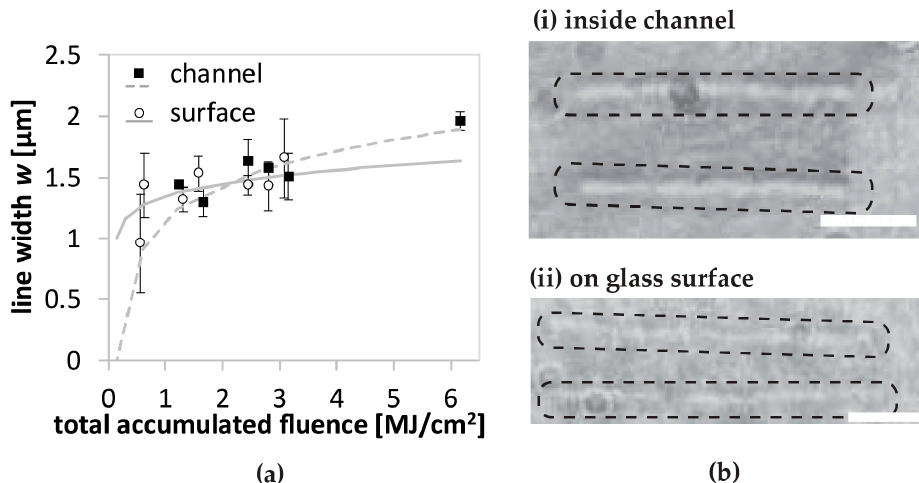
Figure 4. Writing of BSA line pattern inside a glass microchannel when using 50% w/w glycerol as a solvent and a 54-MHz, 525-nm femtosecond laser. ( a ) Line width w vs. total accumulated fluence for line patterns on top of the glass surface and inside the glass channel. Solid and dashed lines indicate fitting based on a two-photon polymerization scheme with R 2 = 0.524 (surface) and R 2 = 0.741 (channel), respectively. These line widths were observed for laser powers of 3.385–6.093 mW with scanning velocities of 0.05–0.5 μ m/s ( n = 4 for on-surface, n = 3 for in-channel fabrication). ( b ) In situ CCD camera images were modified for better visibility. Line patterns are outlined by dashed ellipses. ( i ) Inside, the channel lines written at 6.1 mW and 200 nm/s (upper) and 4.7 mW and 100 nm/s (lower) are shown. ( ii ) On the surface, two lines written at 6.1 mW and 500 nm/s are shown. Scale bars represent 10 μ m.